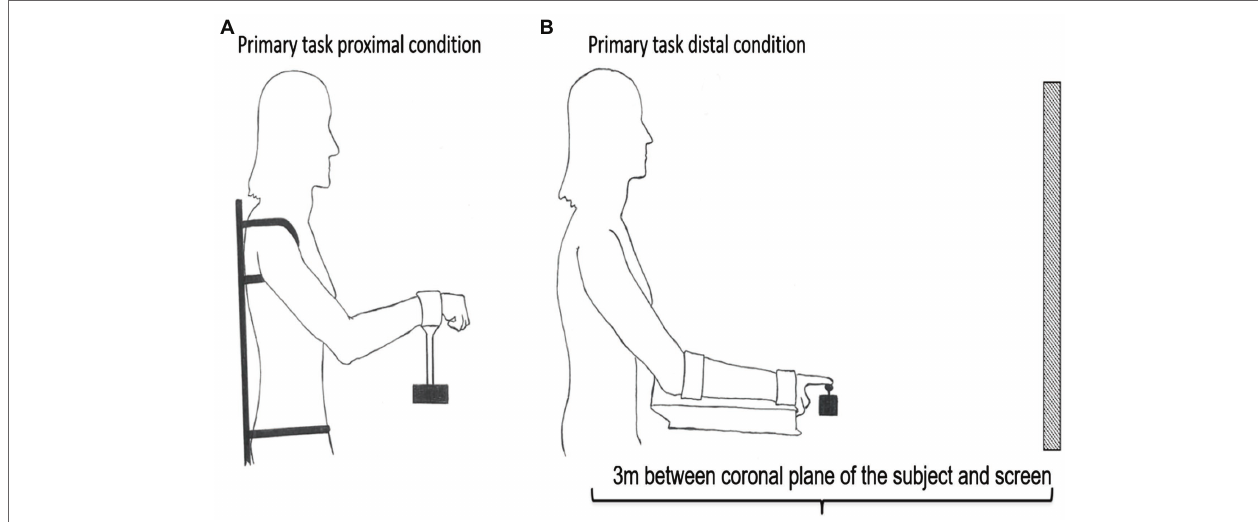
FIGURE 2 | Illustration of the experimental setup of the primary task controlled with either a (A) proximal joystick or a (B) distal joystick. The subject was positioned seating 3 m from the screen in both conditions. In order to prevent mechanical, postural, and synergist muscle contributions in the proximal (A) and distal (B) conditions, the participants’ body positions were constrained by clamps and straps as illustrated. The starting position in the proximal condition was calibrated to 45 between the trunk and overarm (humerus) and 130 between humerus and radius (A) . The starting position in the distal condition was calibrated to 25 between the trunk and overarm, with the underarm resting in a horizontal position (B) .